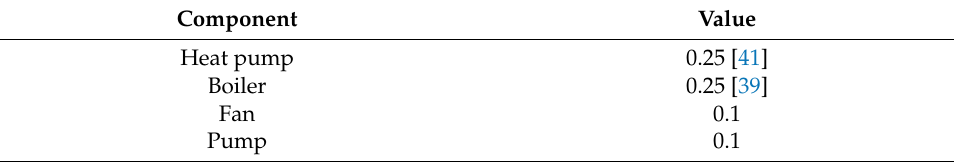
Table 3. Turndown